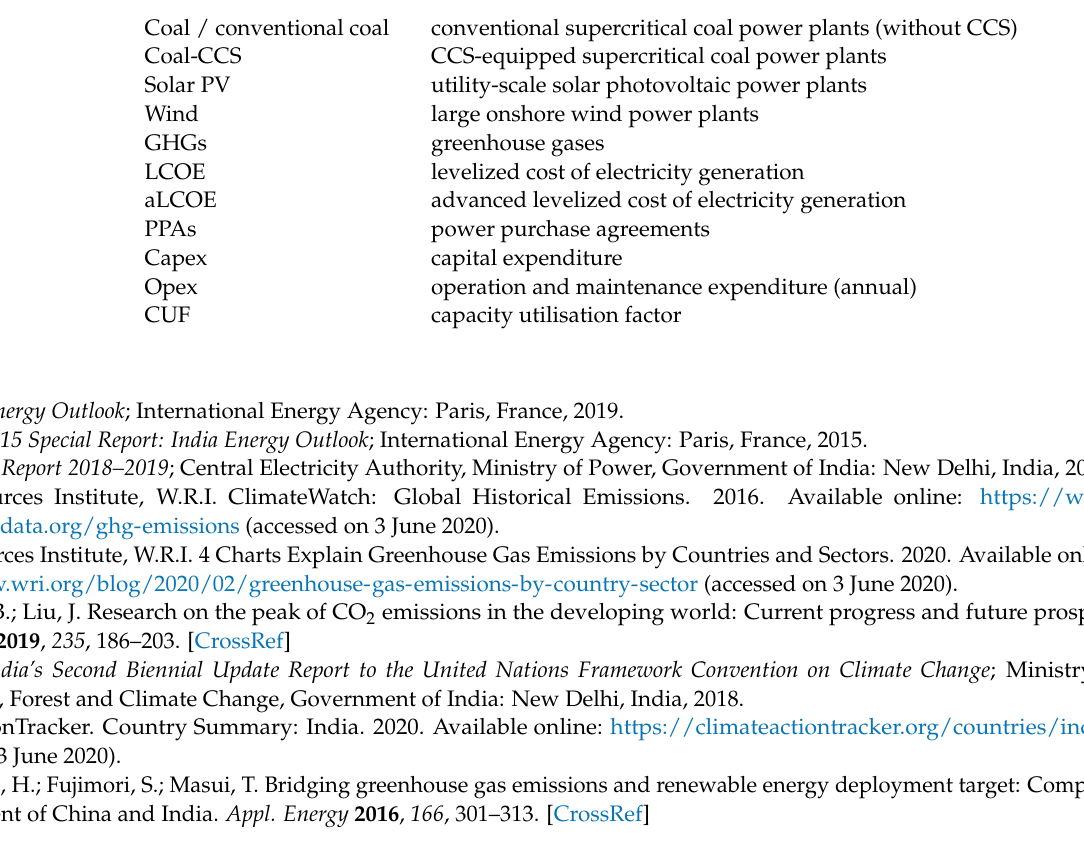
Footprint: Table S4.1: Data and assumptions used for estimating Life Cycle Water Consumption, Table S4.2: Meta-analysis on the percentage increase in the operational water consumption of coal power plants after integrating with CCS, Section S5: What it takes to run 150 GW of coal-CCS for 40 years (assumptions and first order